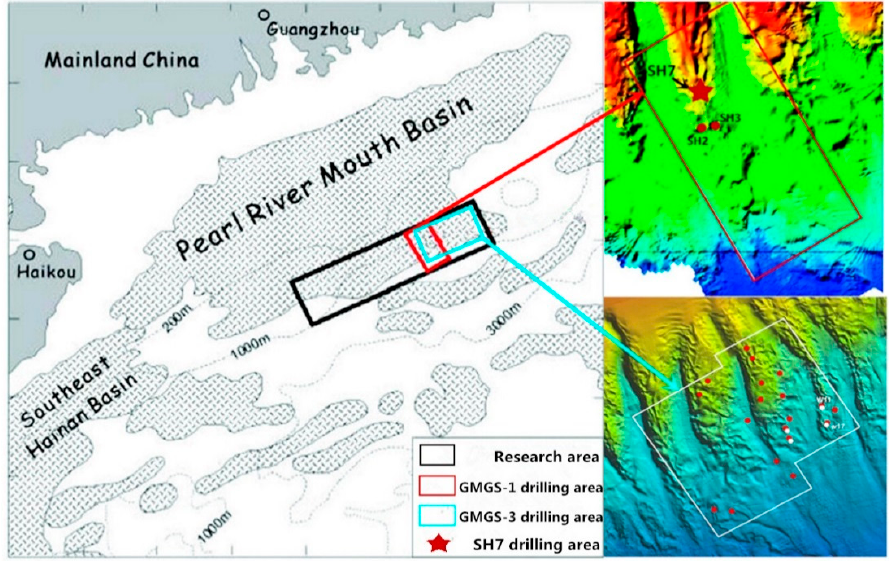
Figure 1. Location of the research area and drilling sites in the Shenhu area, on the northern slope of the South China Sea.